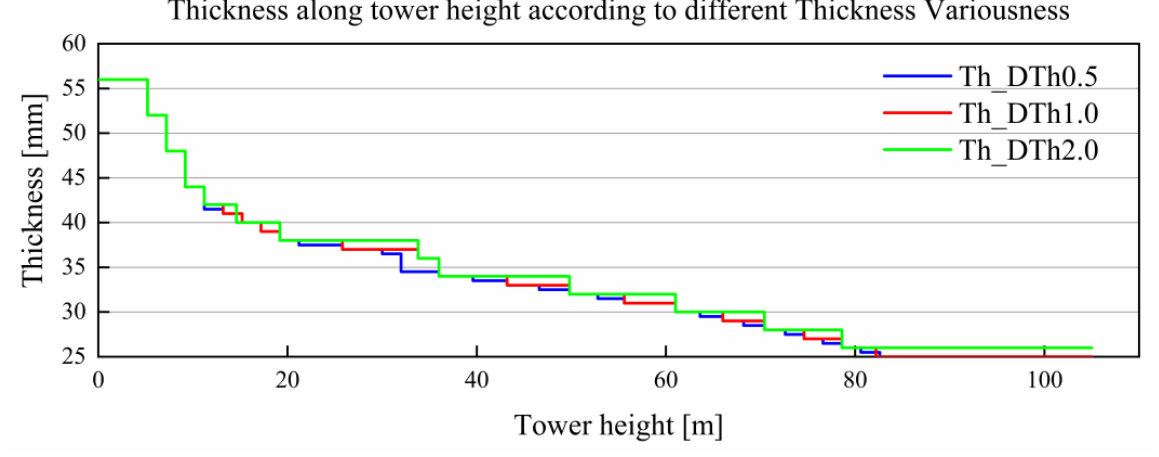
Figure 10. Thickness along tower height according to different thickness variousness.